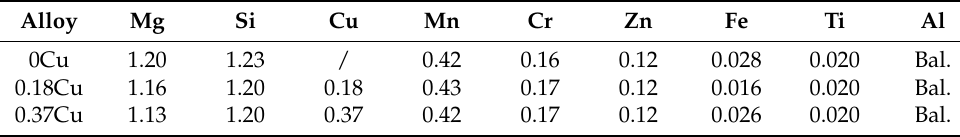
Table 2. Chemical composition table of the Al-Mg-Si-(xCu) alloys.